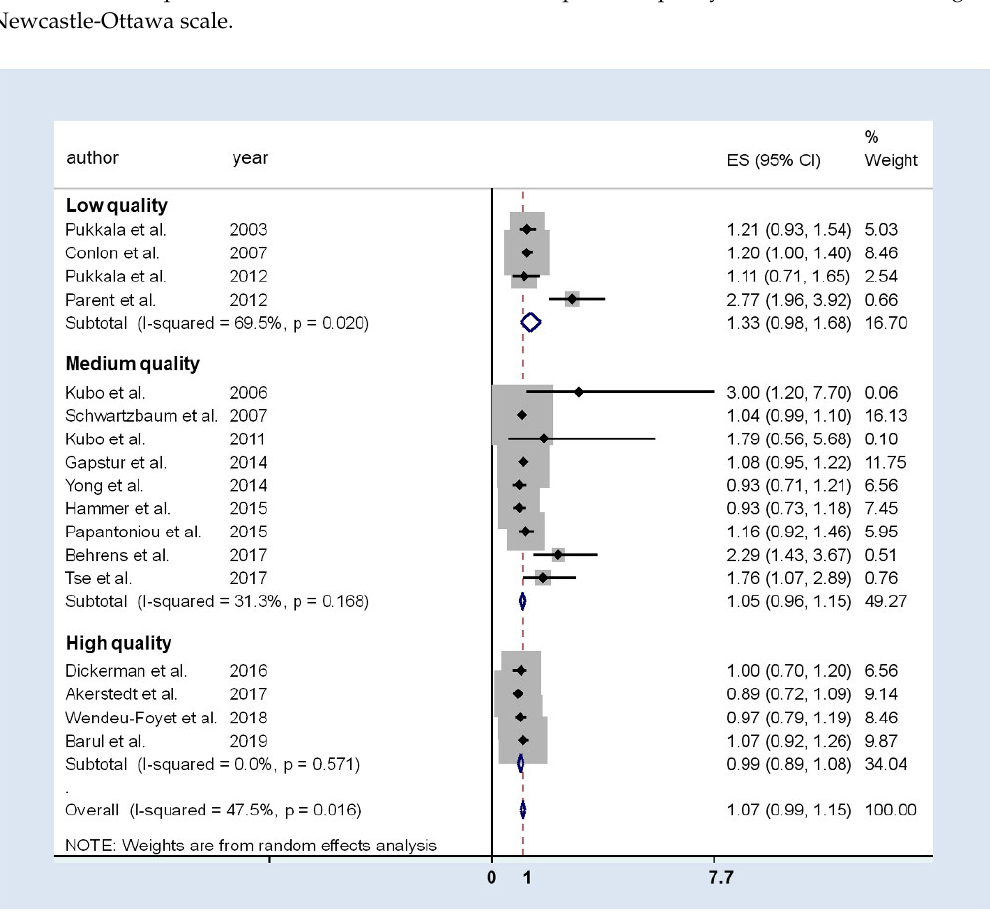
Figure 3. Forest ‐ plot of the association between prostate cancer and rotatory or night shift work. The studies are grouped into three categories depending on the NOS quality detected. are grouped into three categories depending on the NOS quality